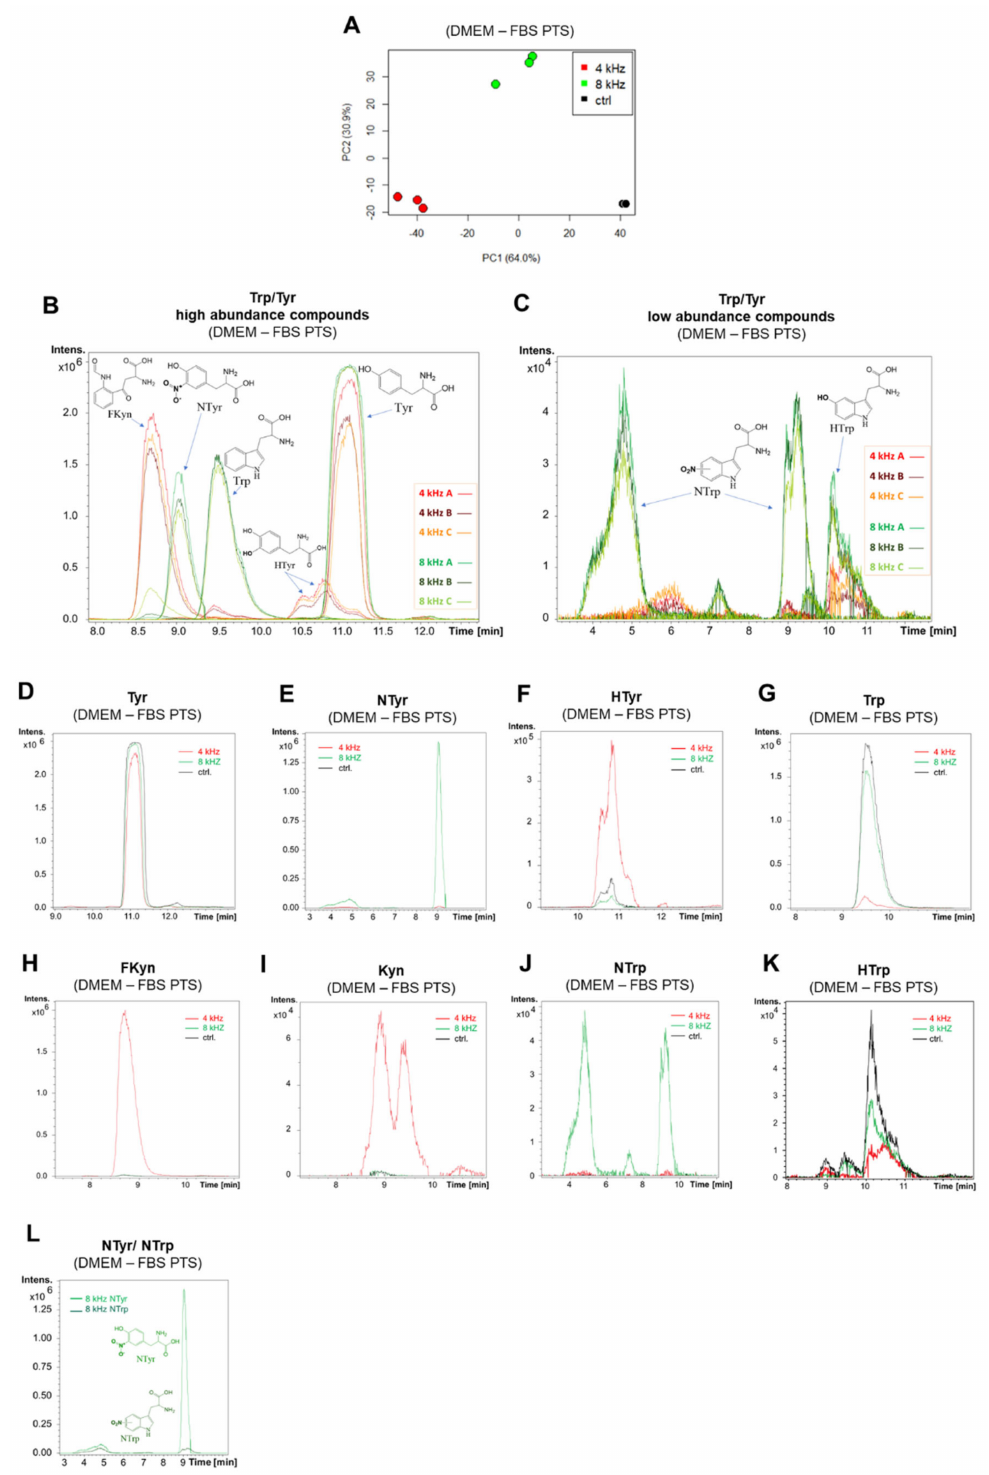
Figure 5. Amino acid degradation in DMEM–FBS PTS. A PCA score plot obtained from the finger- printing analysis of the HPLC-TOFMS data ( A ). Extracted ion chromatograms (EICs) of the high and low abundance compounds in the triplicates of the 4 kHz and 8 kHz CAP-treated samples ( B , C ). EICs of the different metabolites detected in the treated and control samples ( D – K ). EIC comparison between the NTrp and NTyr in the same 8 kHz sample ( L ). All of the compounds were tentatively